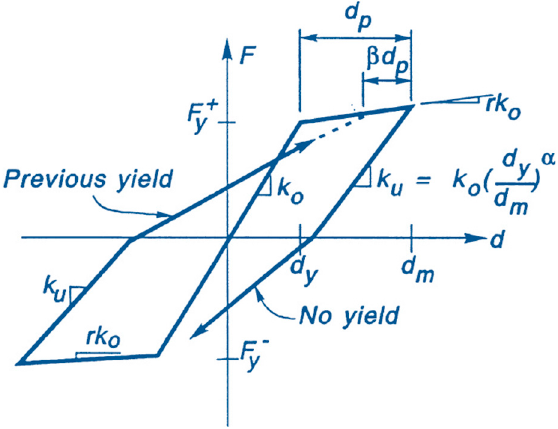
Figure 1. The modified Takeda model (adopted from reference [20]).